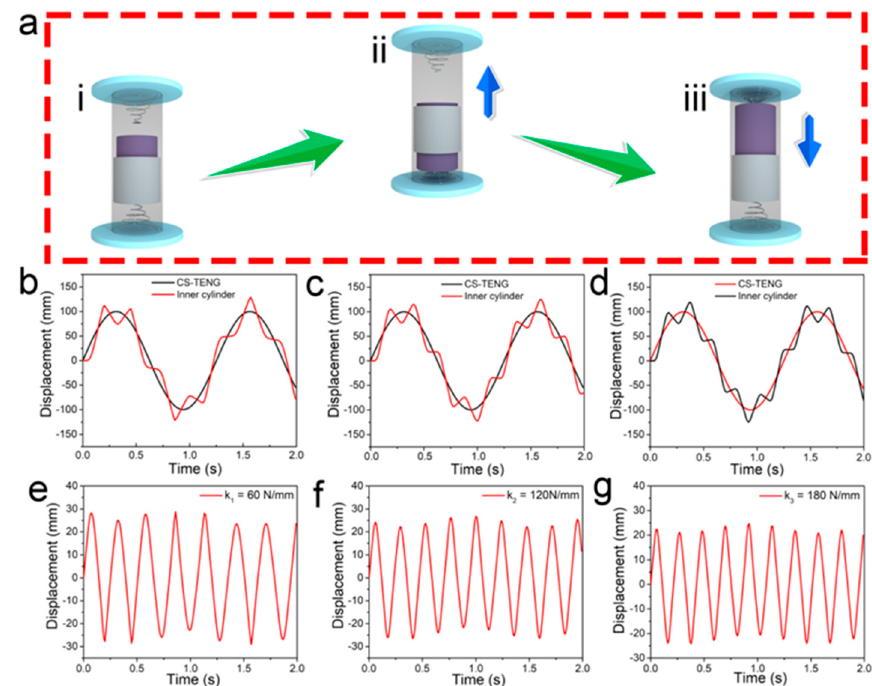
Figure 2. ( a ) Illustration of the CS-TENG’s movement during operation, reflecting the relative position of the inner cylinder to the outer tube. Finite element analysis of the CS-TENG using ANSYS: ( b – d ) motion trajectories of the CS-TENG device and the inner cylinder, and ( e – g ) the normalized displacement of the inner cylinder when using springs with stiffness coefficients of k 1 = 60 N/mm, k 2 = 120 N/mm, and k 3 = 180 N/mm, respectively.